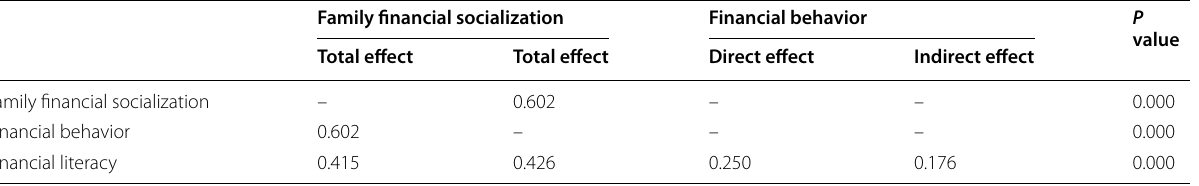
Table 5 Relationship between variables